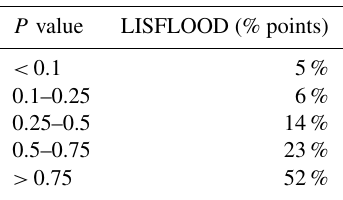
Table B2. Overview of the performance of the Gumbel distribution calculated with the Cramér–von Mises criterion.